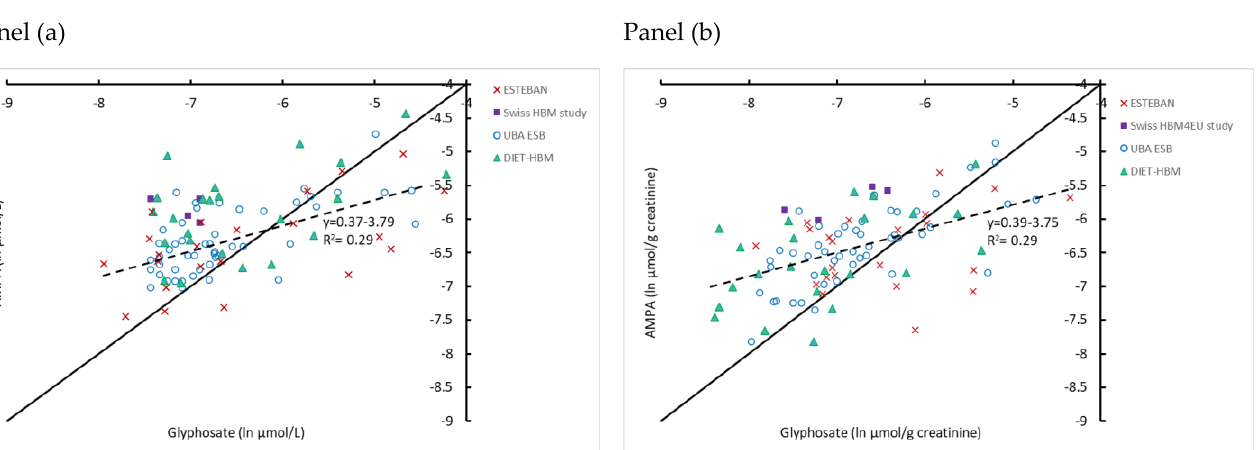
Figure 2. HBM4EU harmonized data (Germany (UBA ESB), Switzerland (Swiss HBM4EU study), France (ESTEBAN), Iceland (DIET-HBM)) for glyphosate and AMPA in adults. Data (>LOQ) are expressed on a natural logarithmic scale. The 1:1 line (full line) is indicated. Panel ( a ): µg/L scale and panel ( b ): µg/g creatinine scale. Values below LOQ are not included.